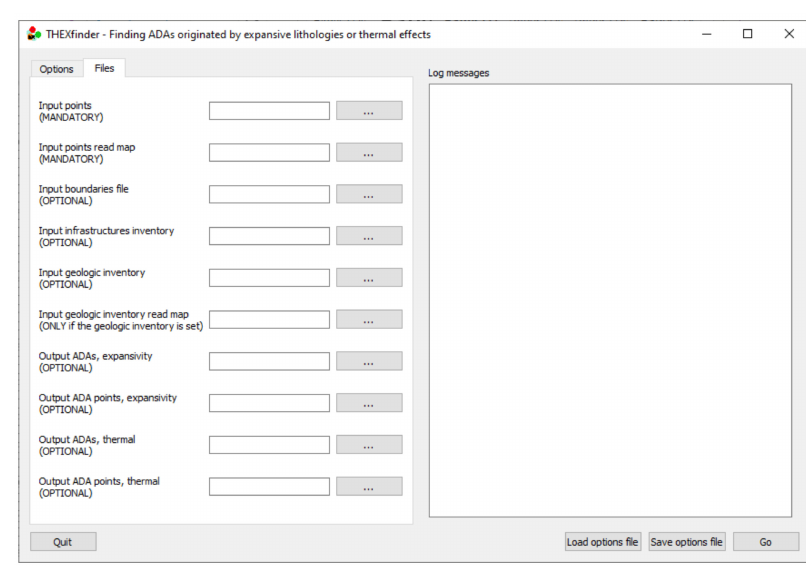
Figure 6. The THEXfinder GUI (options tab).